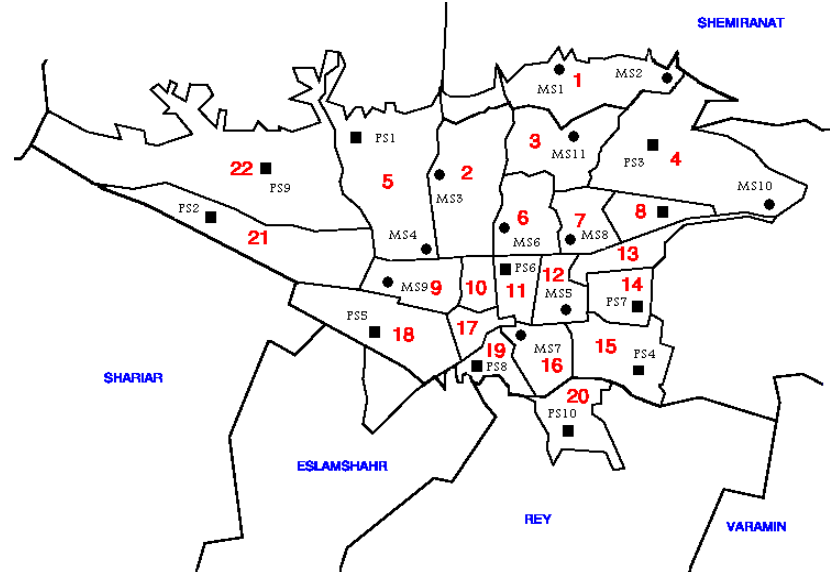
Figure 1. Great Tehran Area map and schematic monitoring site locations Daily mean concentration of the pollutants have been measured on a regular 24 hour basis at the 11 stationary monitoring stations noted as (SM) as dependent